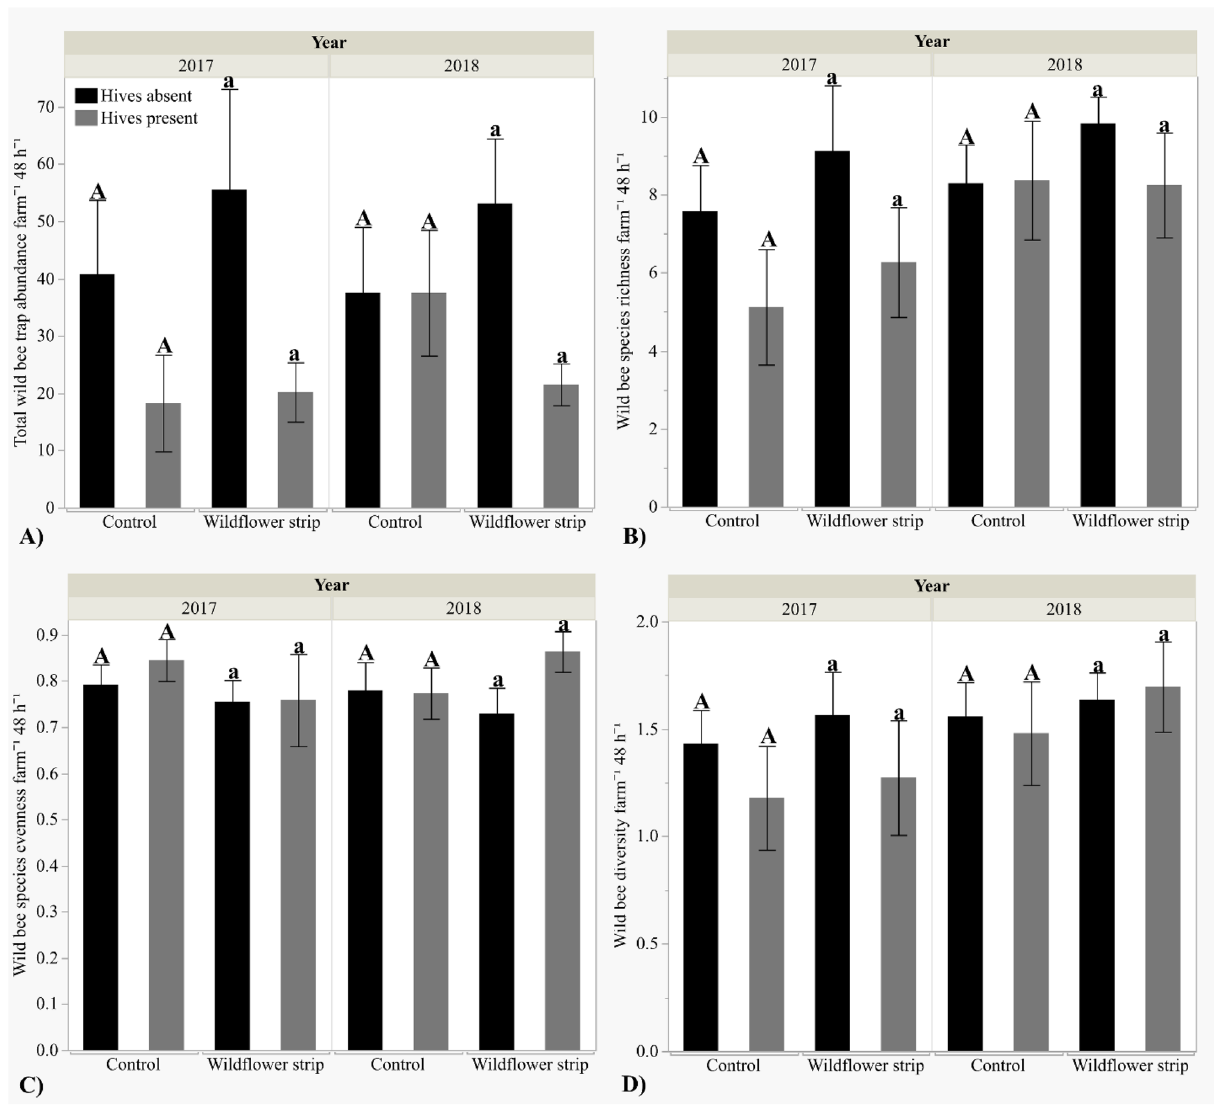
Figure 2. Mean total wild bee abundance, species richness, Shannon–Wiener diversity index, and species evenness (± SE) per farm by wildflower strip and honey bee hive presence/absence. Hive treatment means are compared within each wildflower strip treatment: the same letter indicates means are not statistically significant (α = 0.05). ( A ) Abundance, ( B ) Species richness, ( C ) Diversity, ( D )